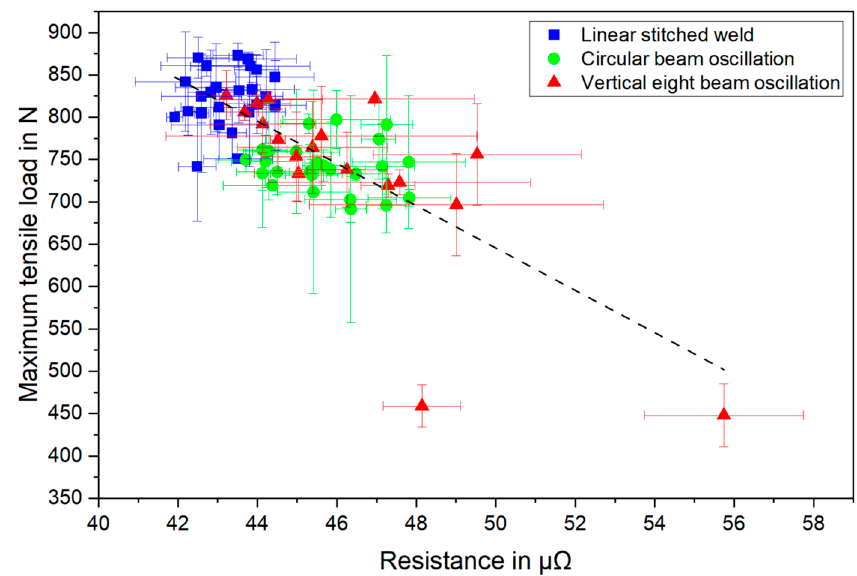
Figure 26. Correlation between tensile strength and electrical resistance for welds produced with linear stitched welding strategy (blue), circular beam oscillation (green), and vertical eight beam oscillation (red); error bars indicate the standard deviation; dashed line indicates the overall trend.